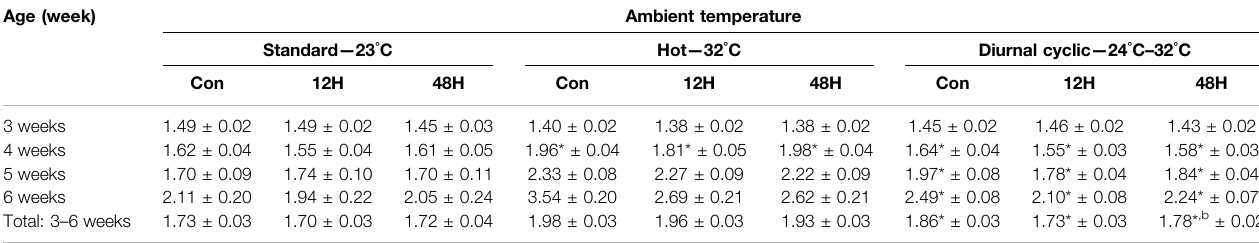
TABLE 5 | Feed-conversion ratios (FCR) of broilers that were exposed to different hypoxia regimes during embryonic development and then raised under different environmental ambient temperatures (analyzed within each ambient temperature).